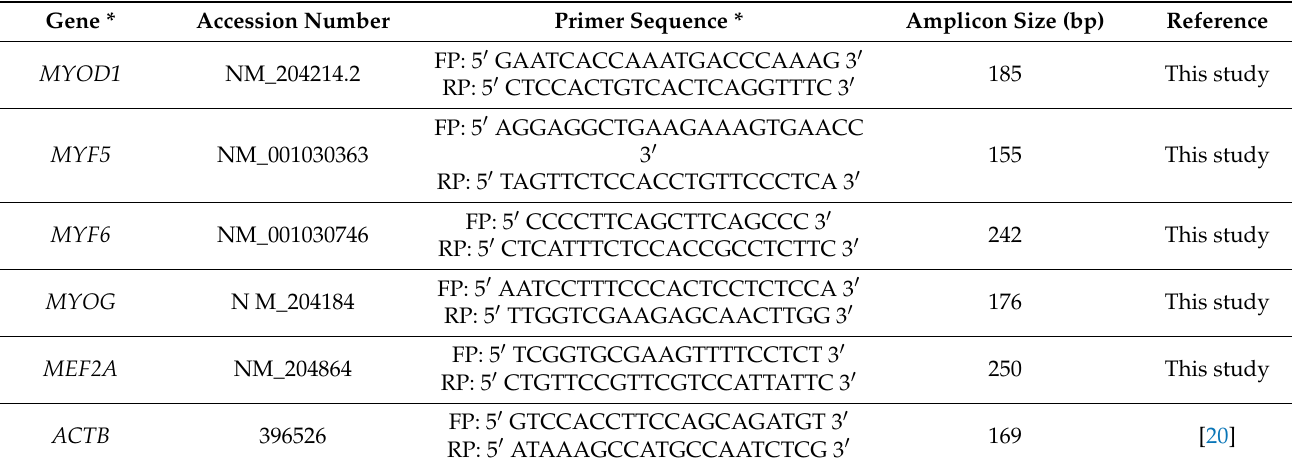
Table 1. Gene specific primer